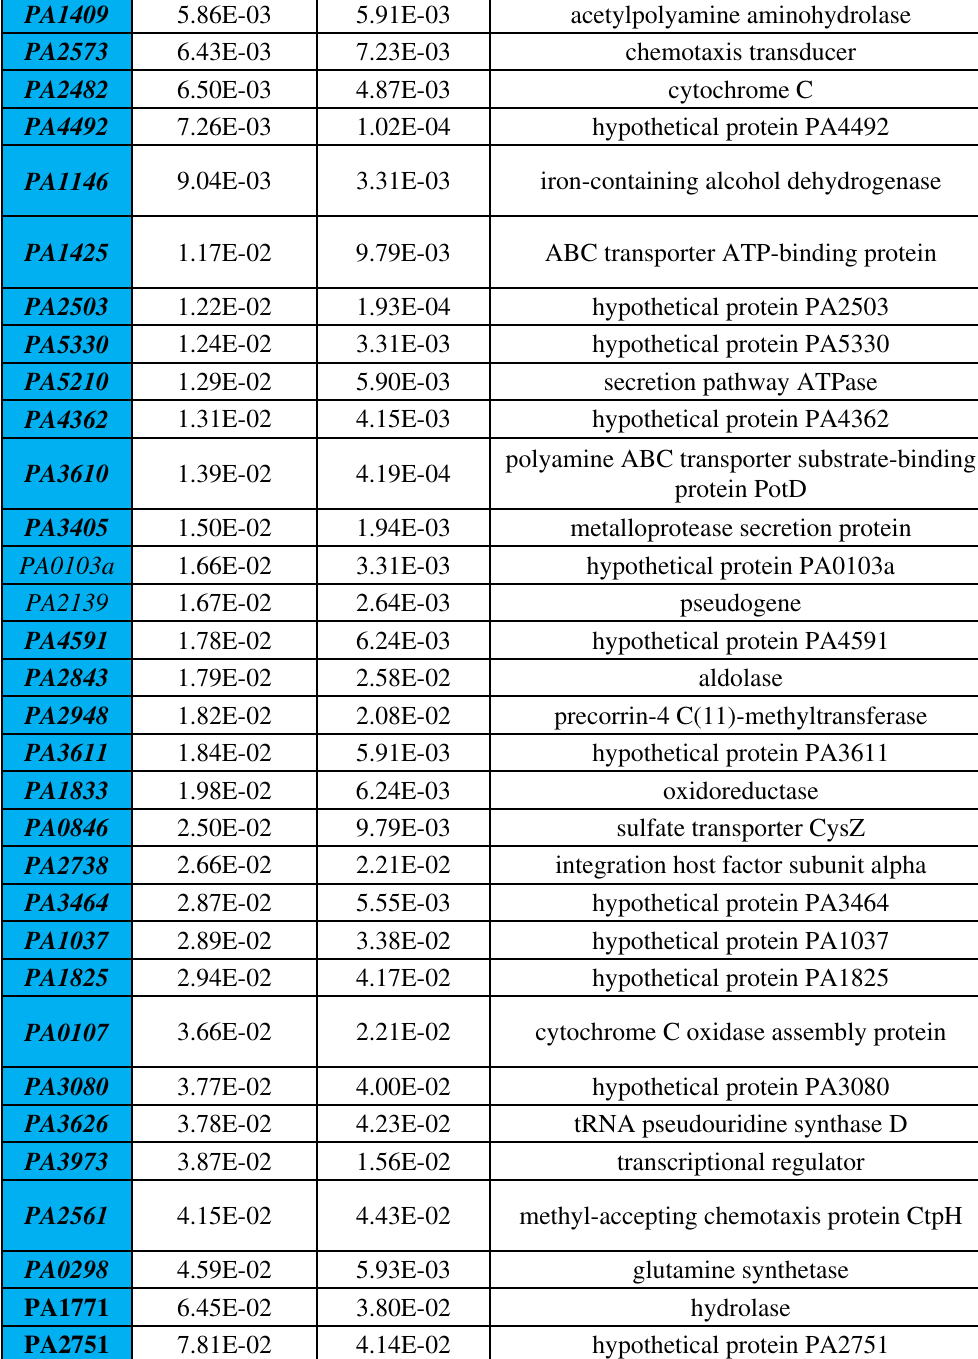
Table 1. Statistically significant DEGs of phoenix colonies. Phoenix colony transcripts were compared to the control lawn to identify genes which were significantly up or down regulated. Red indicates genes which were significantly upregulated and blue indicates genes which were significantly downregulated. Genes in bold were screened using transposon mutants. Genes in italics are shared by both phoenix colonies and VBNC-like